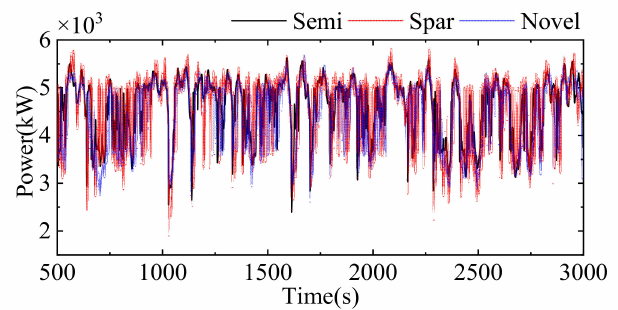
Figure 35. Output power curves of three FOWTs.